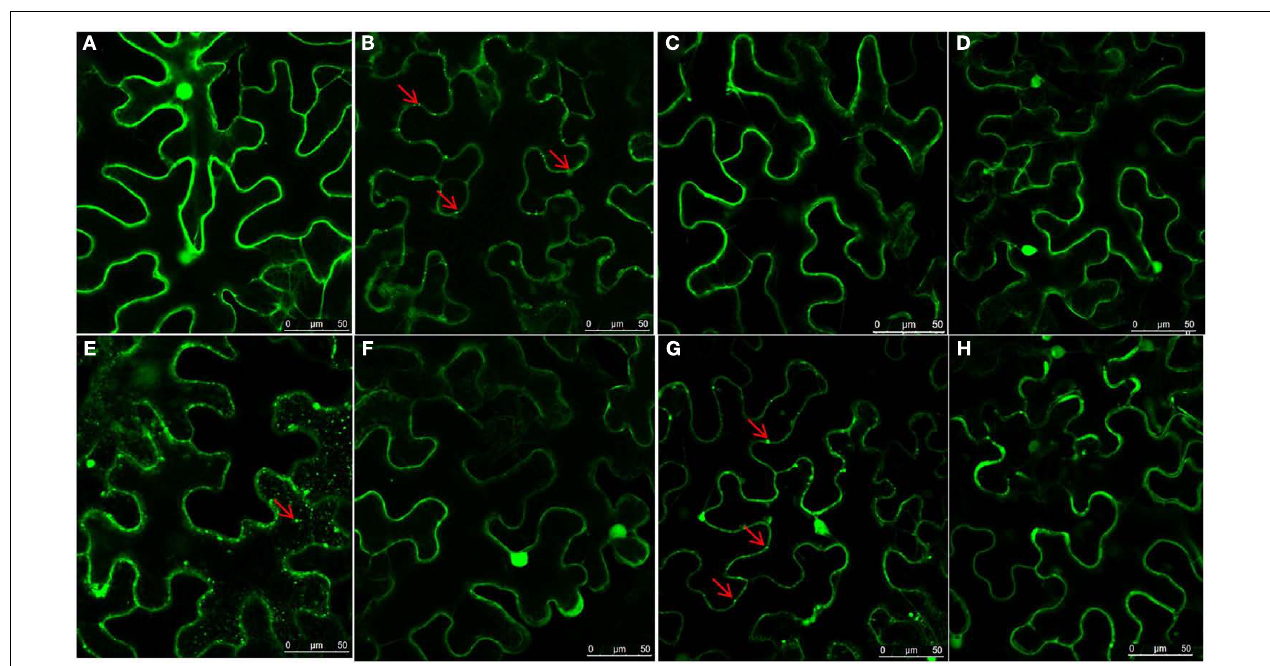
pCHF3-NSvc4 ∆ 106–125 -eGFP (E) , pCHF3-NSvc4 1–106 -eGFP (F) , pCHF3-NSvc4 1–125 -eGFP (G) , and pCHF3-NSvc4 125–286 -eGFP (H) . Harvested leaf samples were examined by confocal microscopy. Arrows indicate the localization of NSvc4 and its mutant fusion protein.